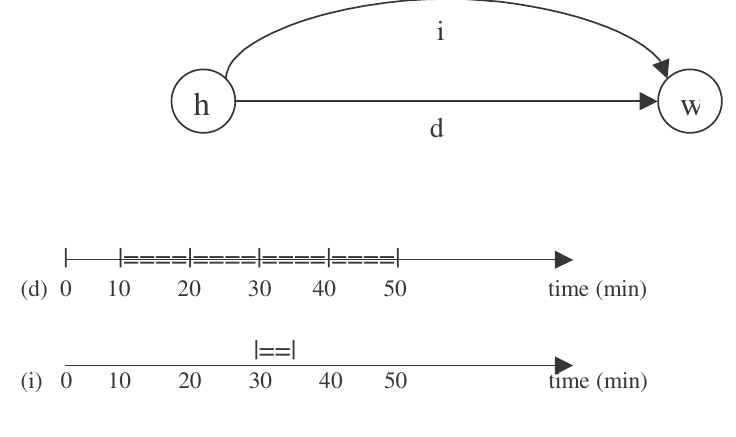
Figure 1. Pessimistic route choice